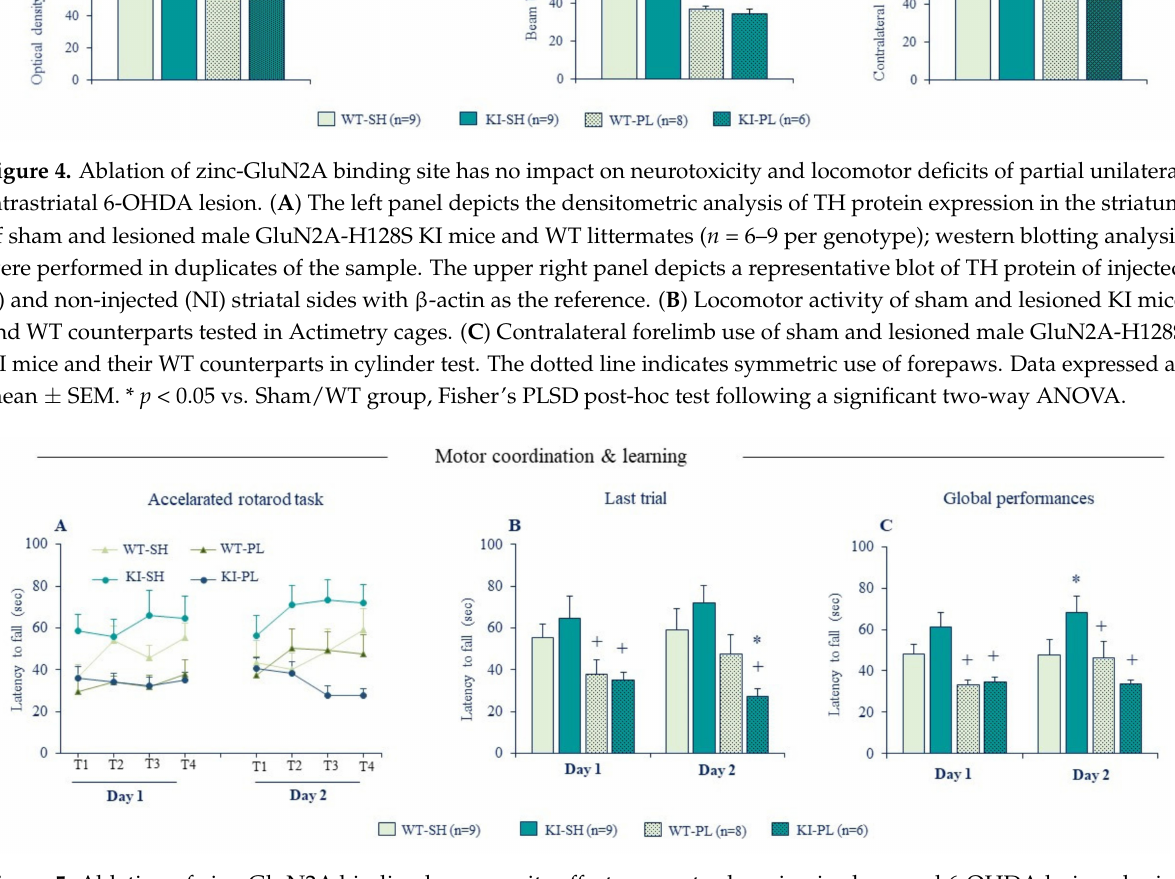
Figure 5. Ablation of zinc-GluN2A binding has opposite effects on motor learning in sham and 6-OHDA lesioned mice. ( A ) Mean latencies to fall from the rotating rod during training sessions (S1, S2, S3, and S4) in day 1 and 2 in the accelerated rotarod task. ( B ) Mean latencies to fall from rotating rod in the 4th training session (last session) in day 1 and 2. ( C ) Mean latencies to fall from rotating rod averaged across all sessions in day 1 and 2. SH: sham (non-lesioned) mice and PL partial unilateral intrastriatal 6-OHDA lesion ( n = 6–9 per genotype). Data expressed as mean ± SEM. * p < 0.05 vs. Sham/WT group, + p < 0.05 vs. Sham/KI group, Fisher’s PLSD post-hoc test following a significant two-way